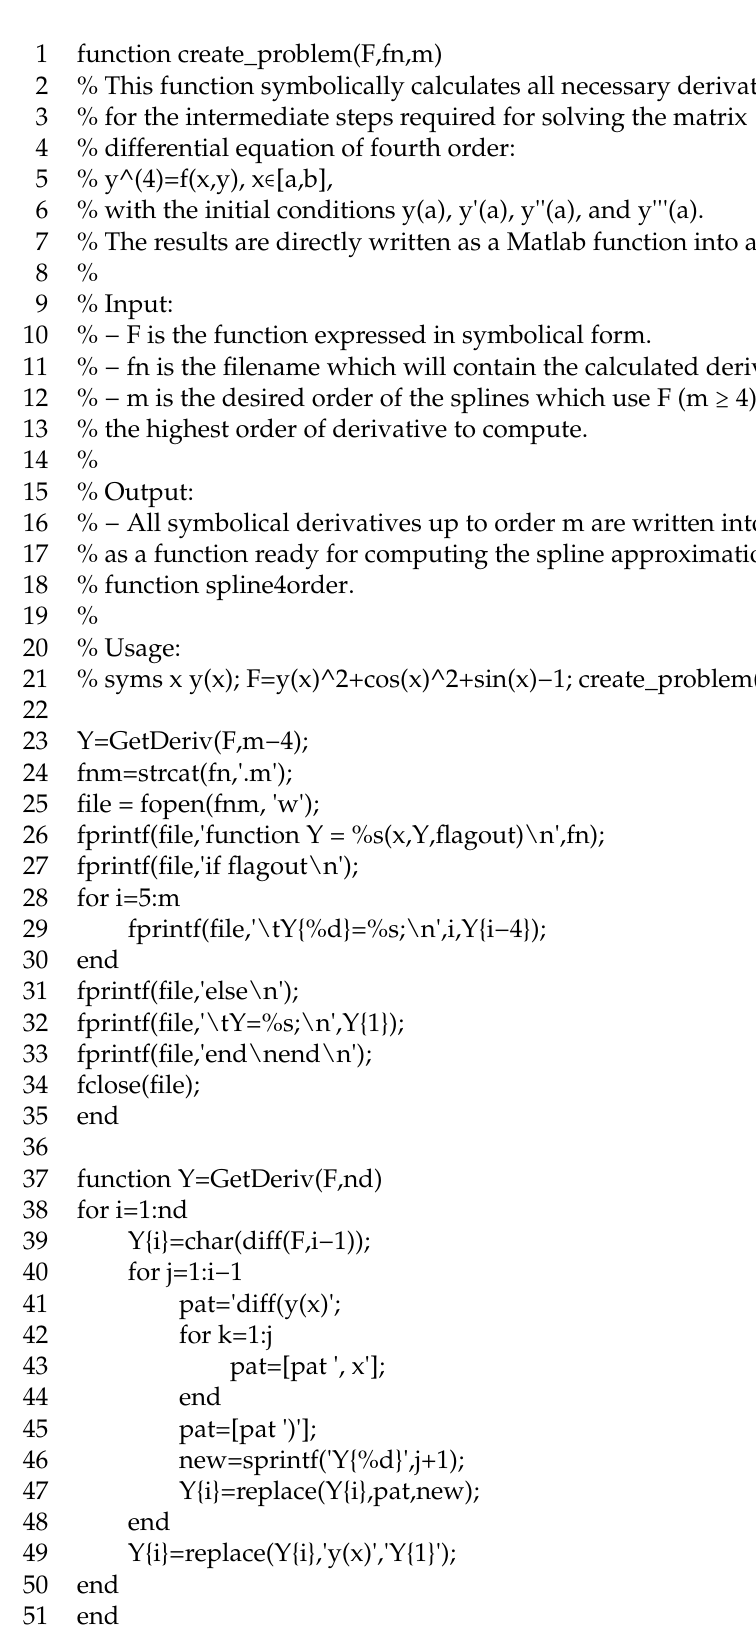
Figure 2. MATLAB function create_problem for automatically generating all symbolical derivatives required by the main code in Figure 1.